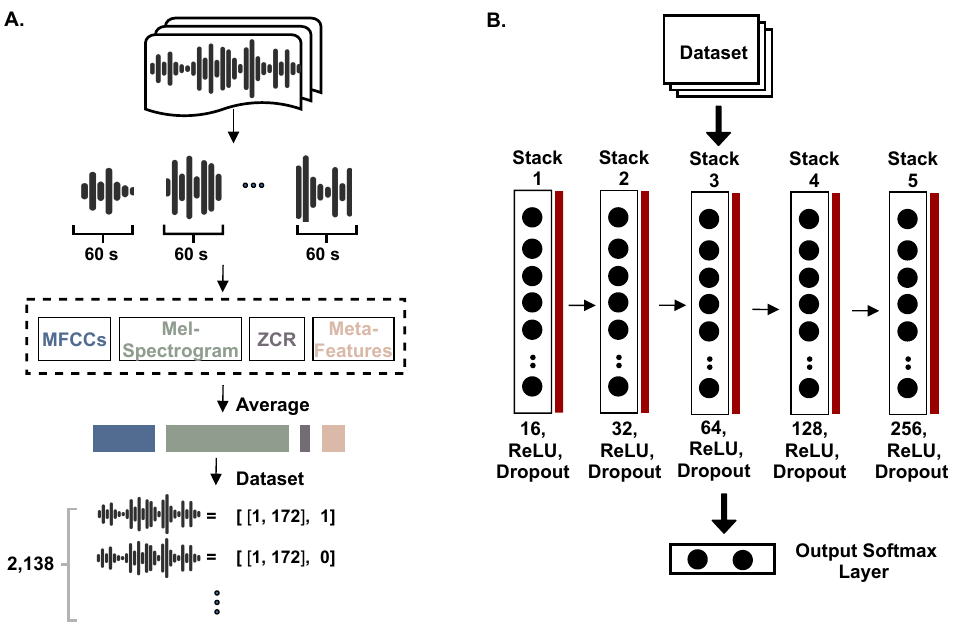
Figure 5. An illustration of implementing the first approach. In ( A ), the dataset is preprocessed and created, while ( B ) shows the utilized DNN model.